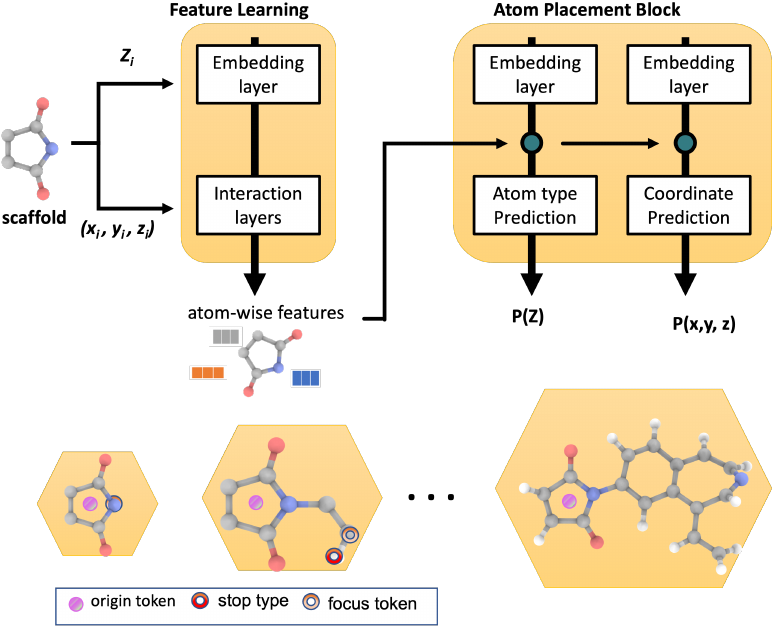
Figure 5. Generative model such as 3D-scaffold [69] can be used to inverse design novel candidates with desired target properties starting from core scaffold or functional